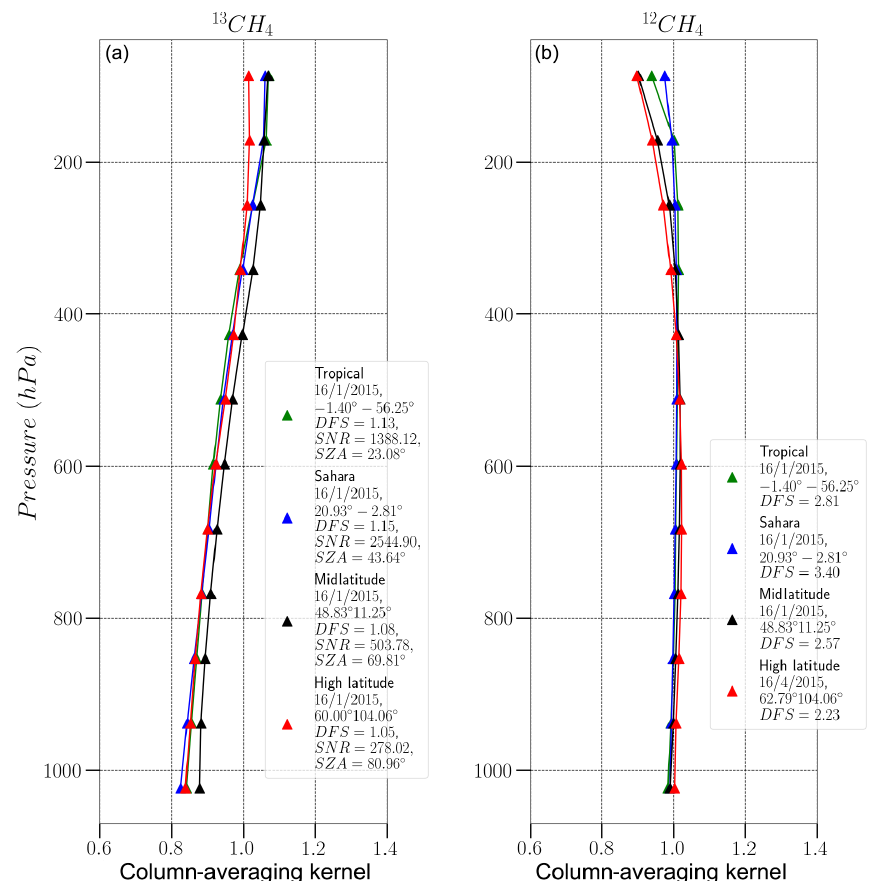
Figure 2. Example column-averaging kernels from synthetic retrievals of 13 CH 4 (a) and 12 CH 4 (b) , from the SWIR1 channel of S5/UVNS. The blue plot is an example retrieval over the Sahara, the red plot is over Siberia (high latitude), the green plot is over the Amazon rainforest (tropical), and the black plot is temperate Europe (midlatitude). Metadata associated with each retrieval are highlighted in the legend.